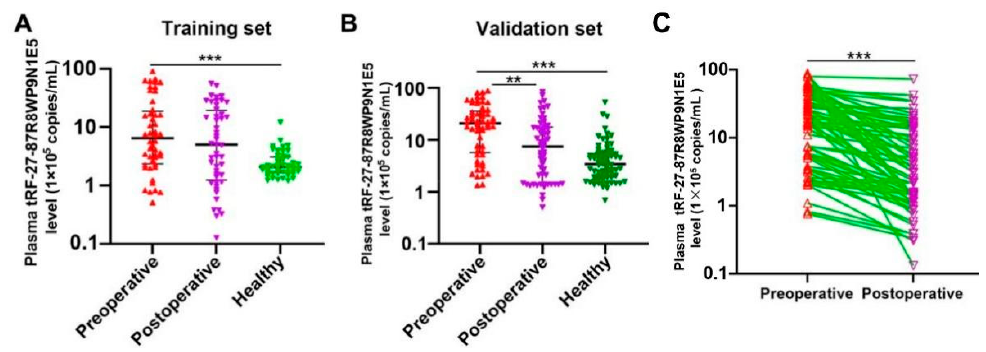
Figure 5. Plasma tRF-27 levels in patients with preoperative and postoperative gastric cancer and healthy individuals. Data are presented as medians (interquartile ranges from 25% to 75%). ( A ) Training set. Patients with preoperative gastric cancer ( n = 48); patients with postoperative gastric cancer ( n = 48); and healthy individuals ( n = 48). ( B ) Validation set. Patients with preoperative gastric cancer ( n = 58); patients with postoperative gastric cancer ( n = 58); and healthy individuals ( n =